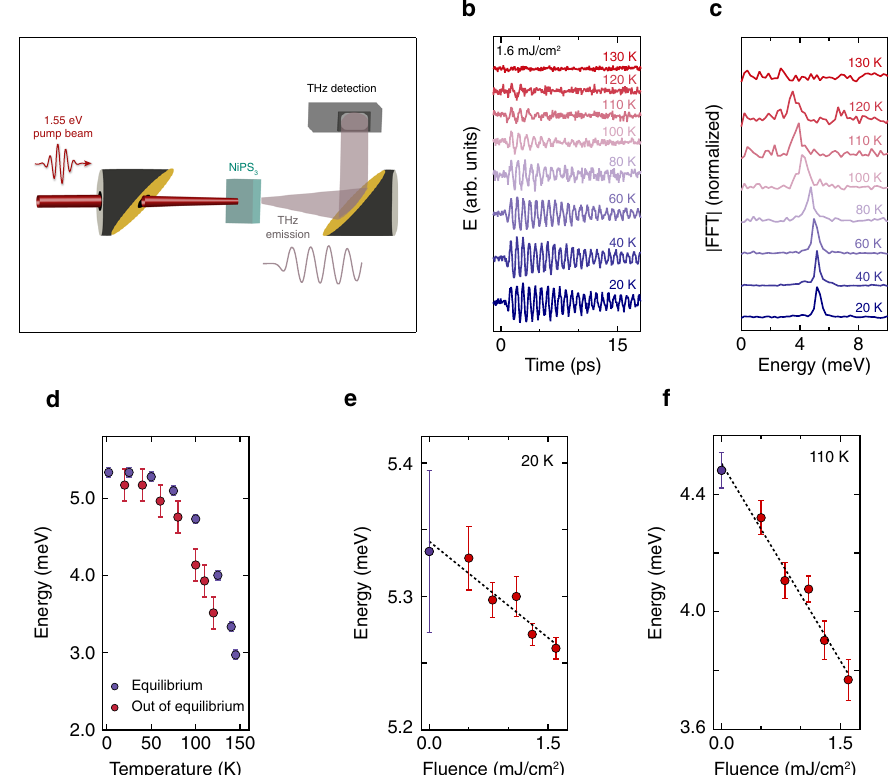
Fig. 3 Evidence for the involvement of the spin – orbit-entangled excitons in the coherent magnon generation. a Schematic of the experimental setup for the THz emission measurements. b Temporal evolution of the emitted THz electric fi eld ( E ) at various temperatures showing coherent magnon oscillations. The absorbed pump fl uence is 1.6 mJ/cm 2 . c Fourier transform of the traces in ( b ). A softening of the energy is observed as the temperature approaches T N . The traces in ( b ) and ( c ) are offset vertically for clarity. d Comparison of the magnon energies from the measurements performed in equilibrium (Fig. 1c) and out of equilibrium ( c ), revealing that the energy of the driven system is redshifted. The error bars for the violet points represent the energy resolution of the time-domain THz experiment, and those for the red points indicate the resolution of the Fourier transform of the THz emission traces. e , f Absorbed pump fl uence dependence of the energy of the magnon oscillations at 20 K ( e ) and 110 K ( f ) obtained from fi ts to the THz emission data (red points). The violet points correspond to the magnon energies in equilibrium at these two temperatures. The energy decreases linearly in both cases. The error bars in ( e ) and ( f ) denote the 95% con fi dence interval of the fi